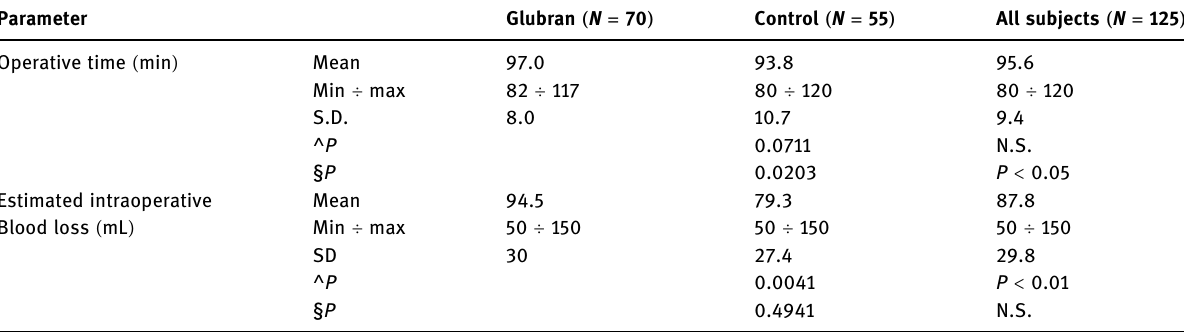
Table 3: Intraoperative parameters Parameter